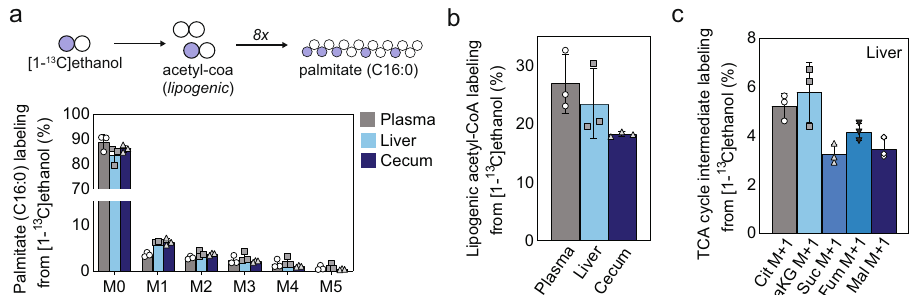
Fig. 1 Contribution of ethanol to acetate and acetyl CoA pool. a Palmitate (C16:0) labeling from [1- 13 C] ethanol (y-axis), Mn represents the nth isotopologue in the mass isotope distribution (MID) for palmitate (C16:0), the most abundant fatty acid (x-axis). b Lipogenic acetyl CoA labeling from [1- 13 C] ethanol ( N = 3). c TCA cycle intermediate labeling from [1- 13 C] ethanol ( N = 3). Cit citrate, α KG α -ketoglutarate, Suc succinate, Fum fumarate, Mal malate. Bar plots represent the mean value and the error bars the standard error. Source data are provided as a Source Data fi